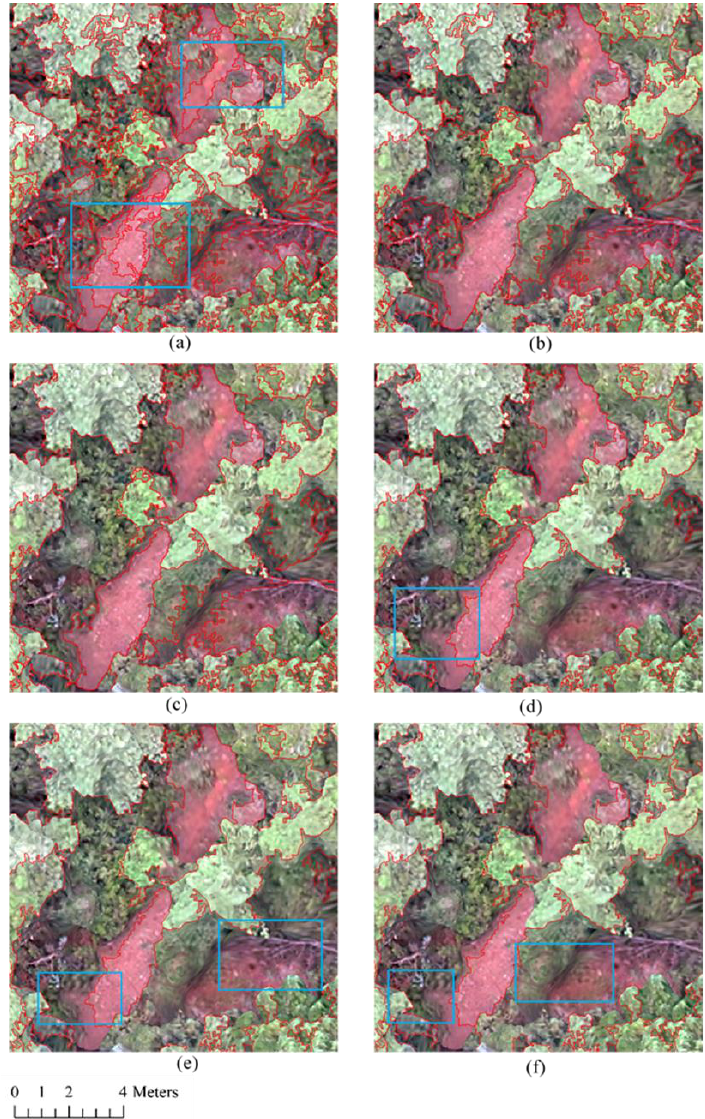
Figure 4. Local segmentation results of different scales: ( a ) scale 50, ( b ) scale 100, ( c ) scale 150, ( d ) scale 200, ( e ) scale 250, ( f ) scale 300. The blue rectangles are used to highlight obvious “ under-seg- mentation and over-segmentation ” .